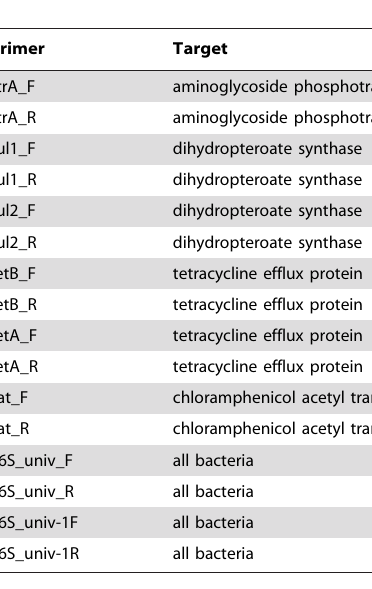
Table 3. List of primers used in this